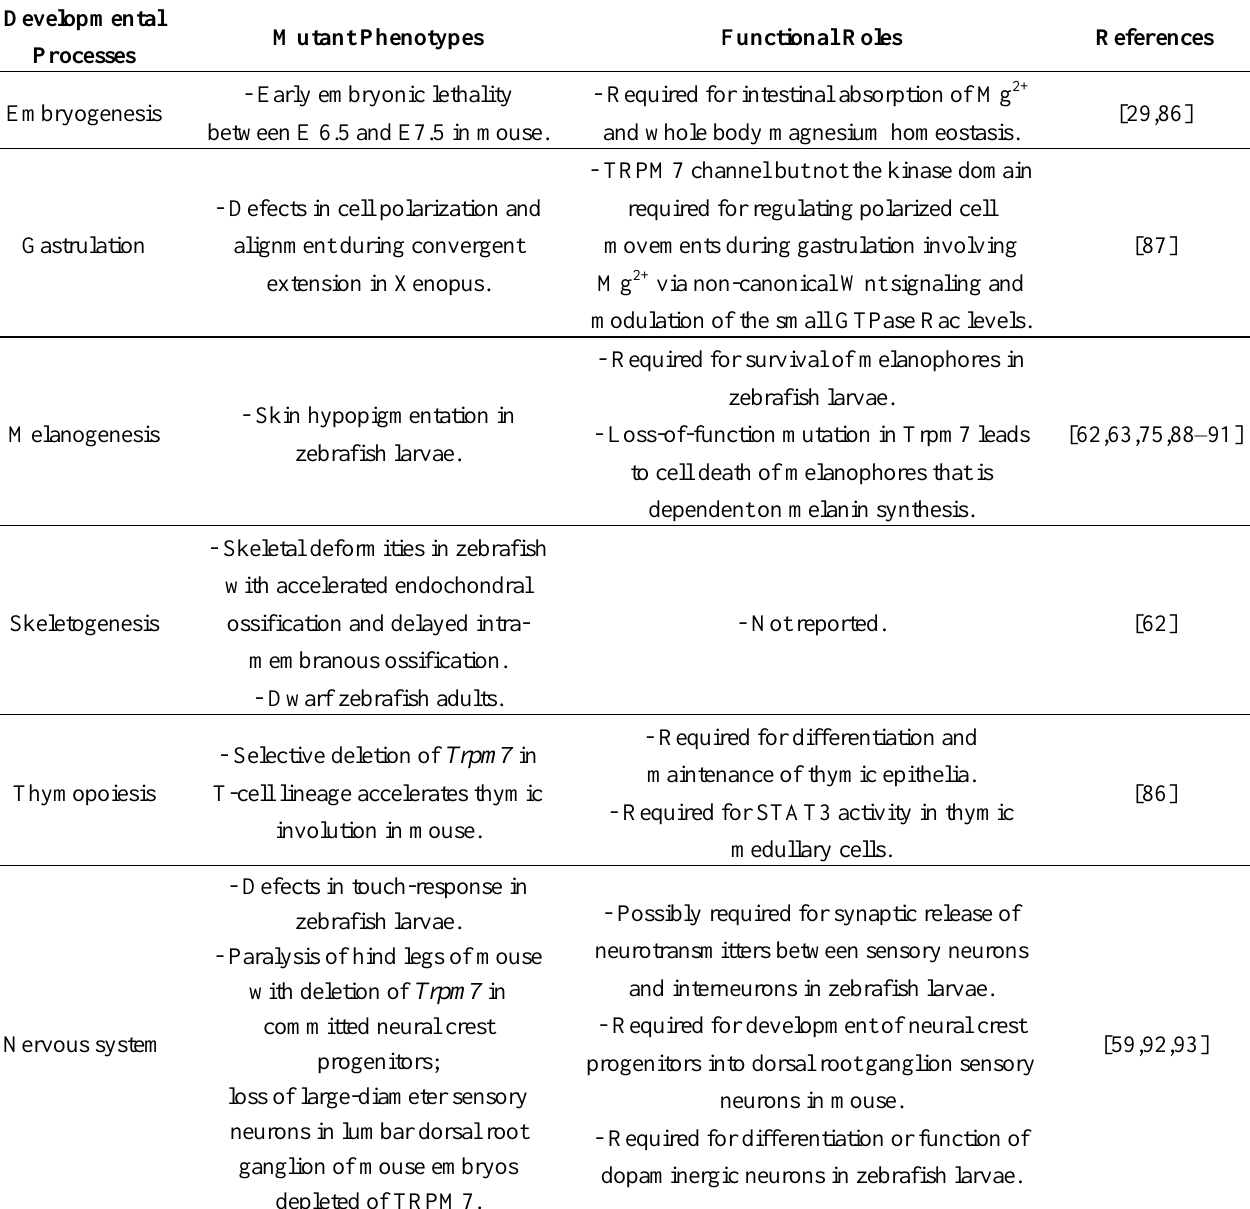
Table 3. Developmental roles of TRPM7